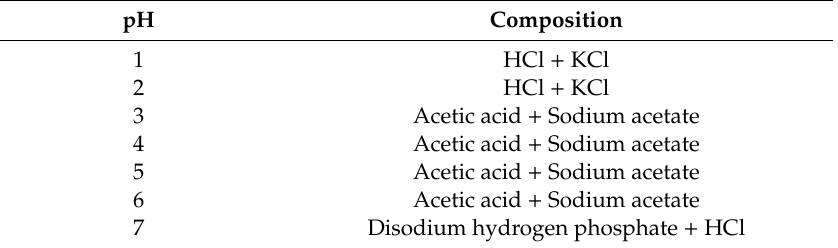
Table 1. Preparation of bu ff er